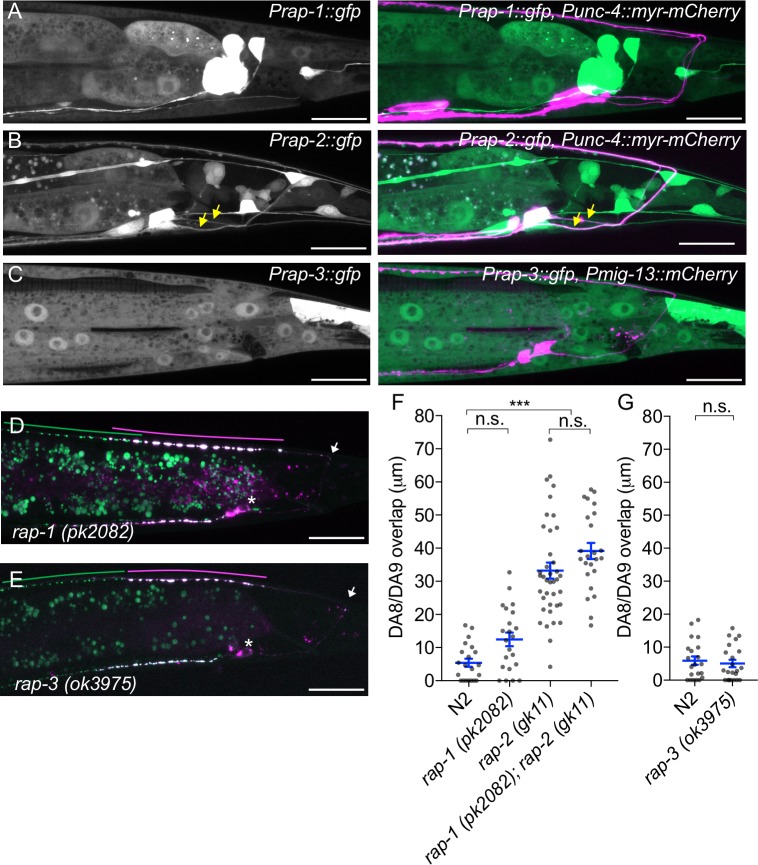
rap-1 and rap-3 are not involved in synaptic tiling of DA8 and DA9.(A–C) Representative images of Prap-1::GFP (wyEx5445) (A), Prap-2::GFP (wyEx5464) (B) and Prap-3::GFP (mizEx194) (C). Merged images with DA markers shown on the right. (D) Representative image of synaptic tiling marker (wyIs446) in rap-1 mutants. (E) Representative image of synaptic tiling marker (wyIs524) in rap-3 mutants. wyIs524 shown given the linkage between wyIs446 and rap-3. Synaptic domains of DA8 and DA9 highlighted with green and magenta lines, respectively. Asterisks: DA9 cell body. Arrows: dorsal commissure of DA9. Scale bars: 20 μm. (F and G) Quantification of DA8/DA9 overlap. Blue bars indicate mean ± SEM. n.s.: not significant; ***p<0.001.